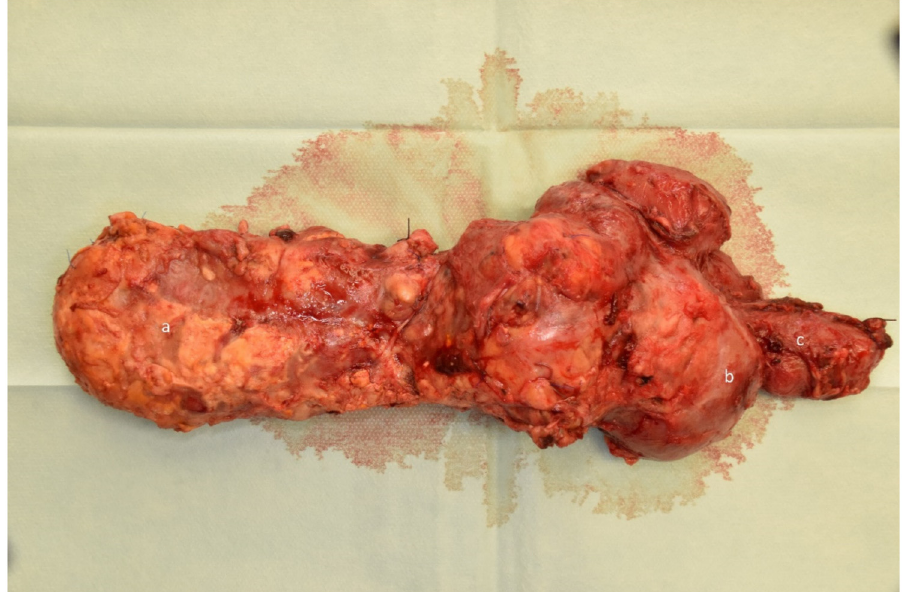
Figure 1. Severe graft pancreatitis. Preparation after graft pancreatectomy with severe graft pan- creatitis. Exocrine drainage was performed via a duodenojejunostomy. Reconstruction of the intestinal passage was performed by jejunojejunostomy after graft pancreatectomy. a = Pancreas graft parenchyma with edematous swelling and graft pancreatitis. b = Pancreas graft duodenum with massive swelling. c = Recipient